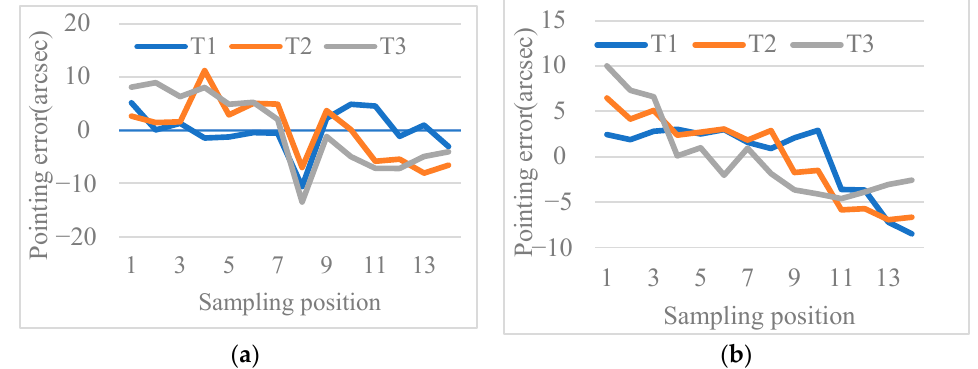
Figure 5. Pointing error of each sampling position for each sub-aperture: ( a ) x-direction and ( b ) y-direction.